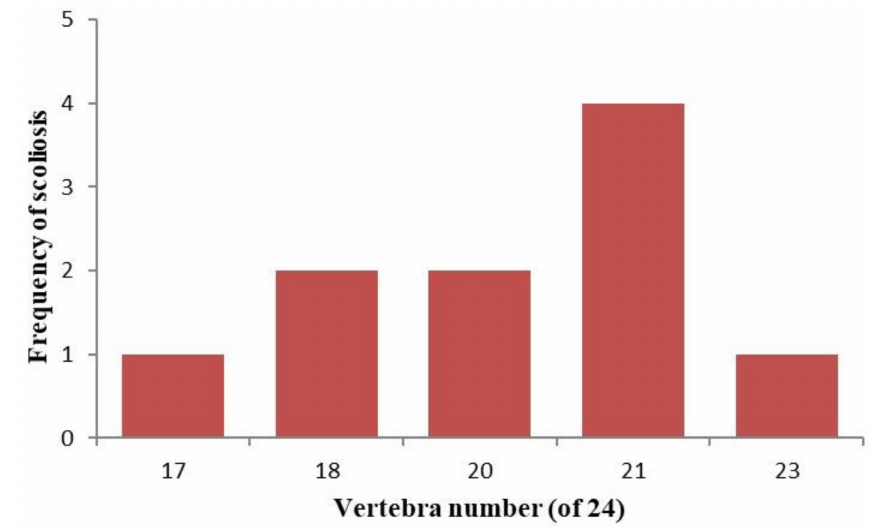
Figure 4. Vertebra number and scoliosis frequency of examined seabreams.